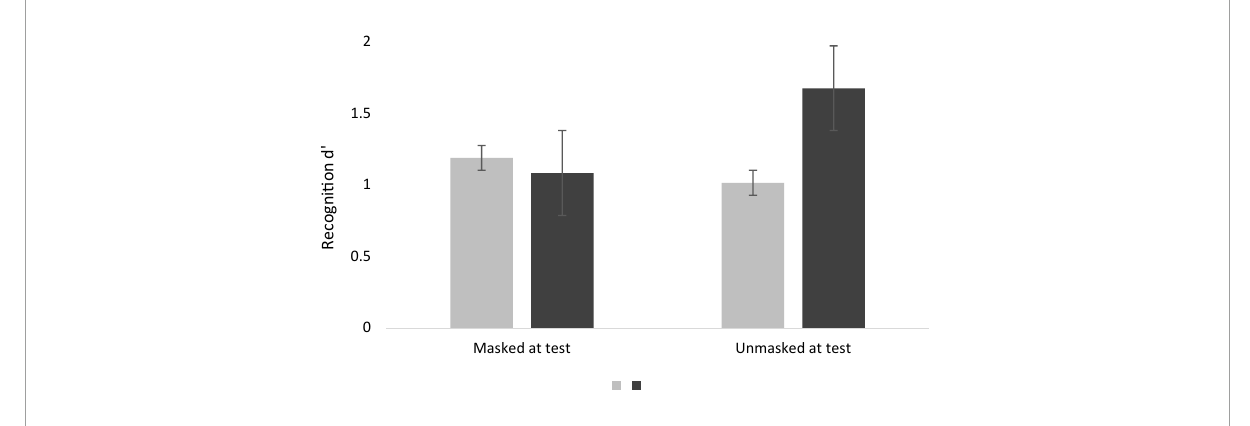
FIGURE3 Mean d (cid:48) scores for masked and unmasked faces at study and test phase. The error bars correspond to the SEM (Standard Error of the Mean). Grey corresponds to masked at study and black to unmasked at